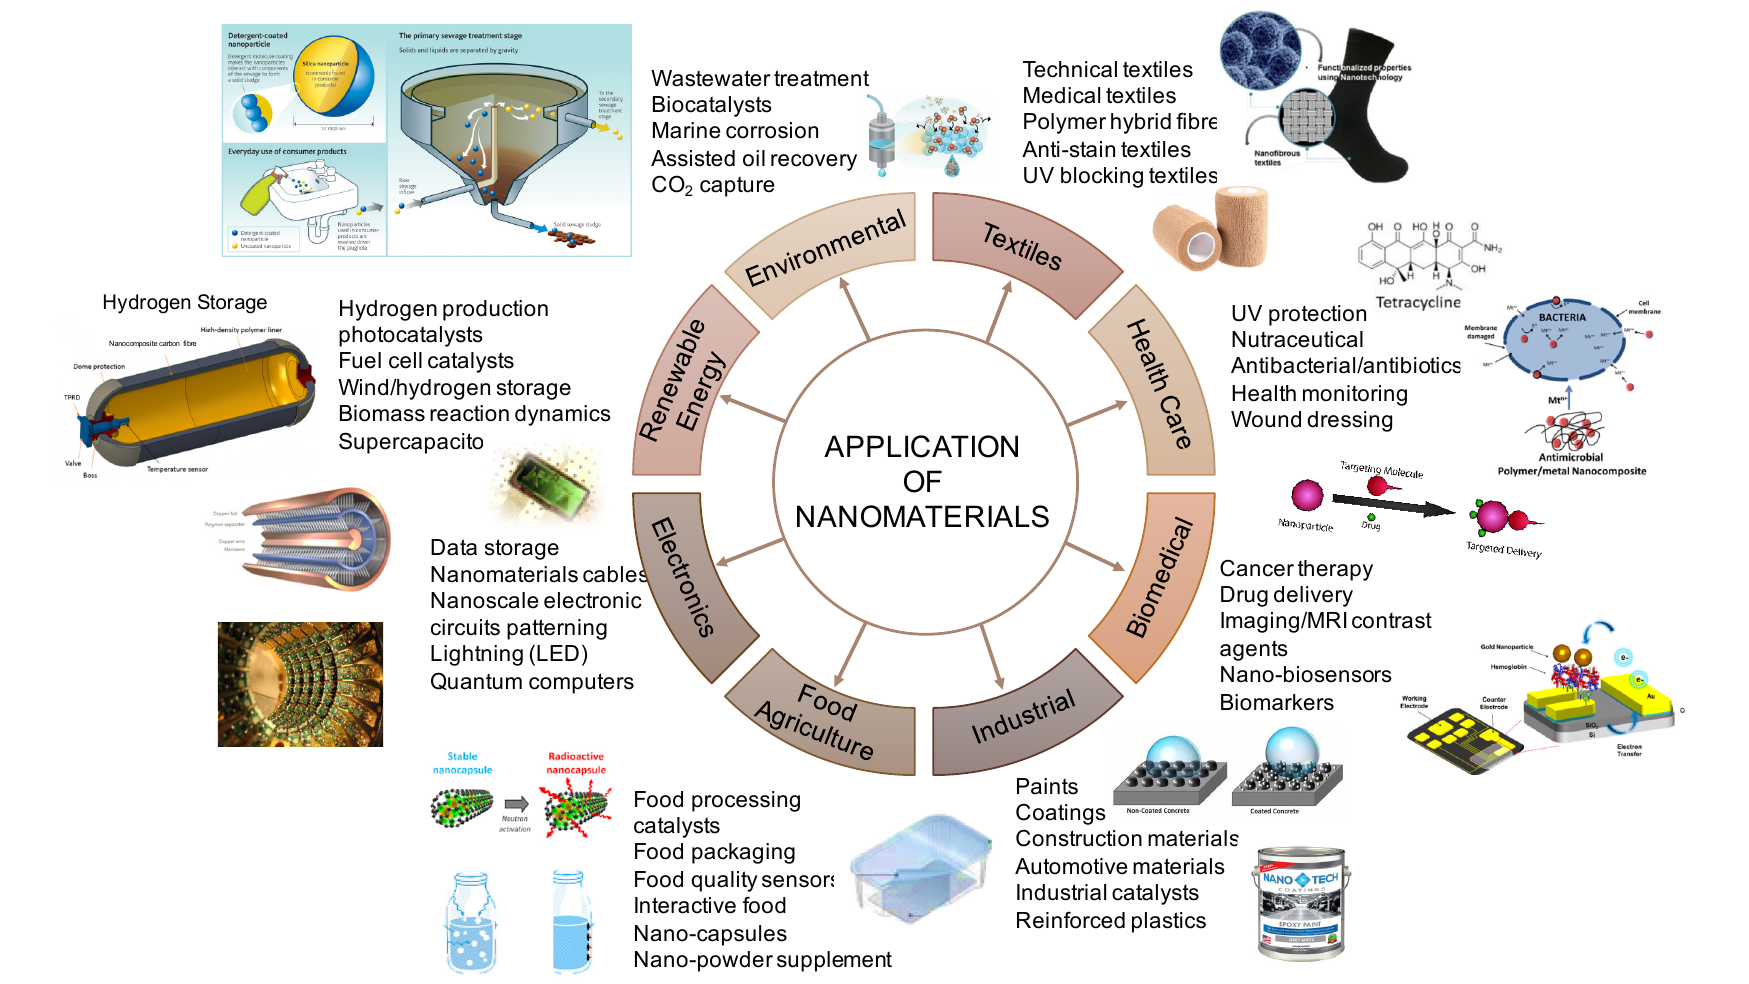
Figure 1. The application of nanomaterials in various sectors.